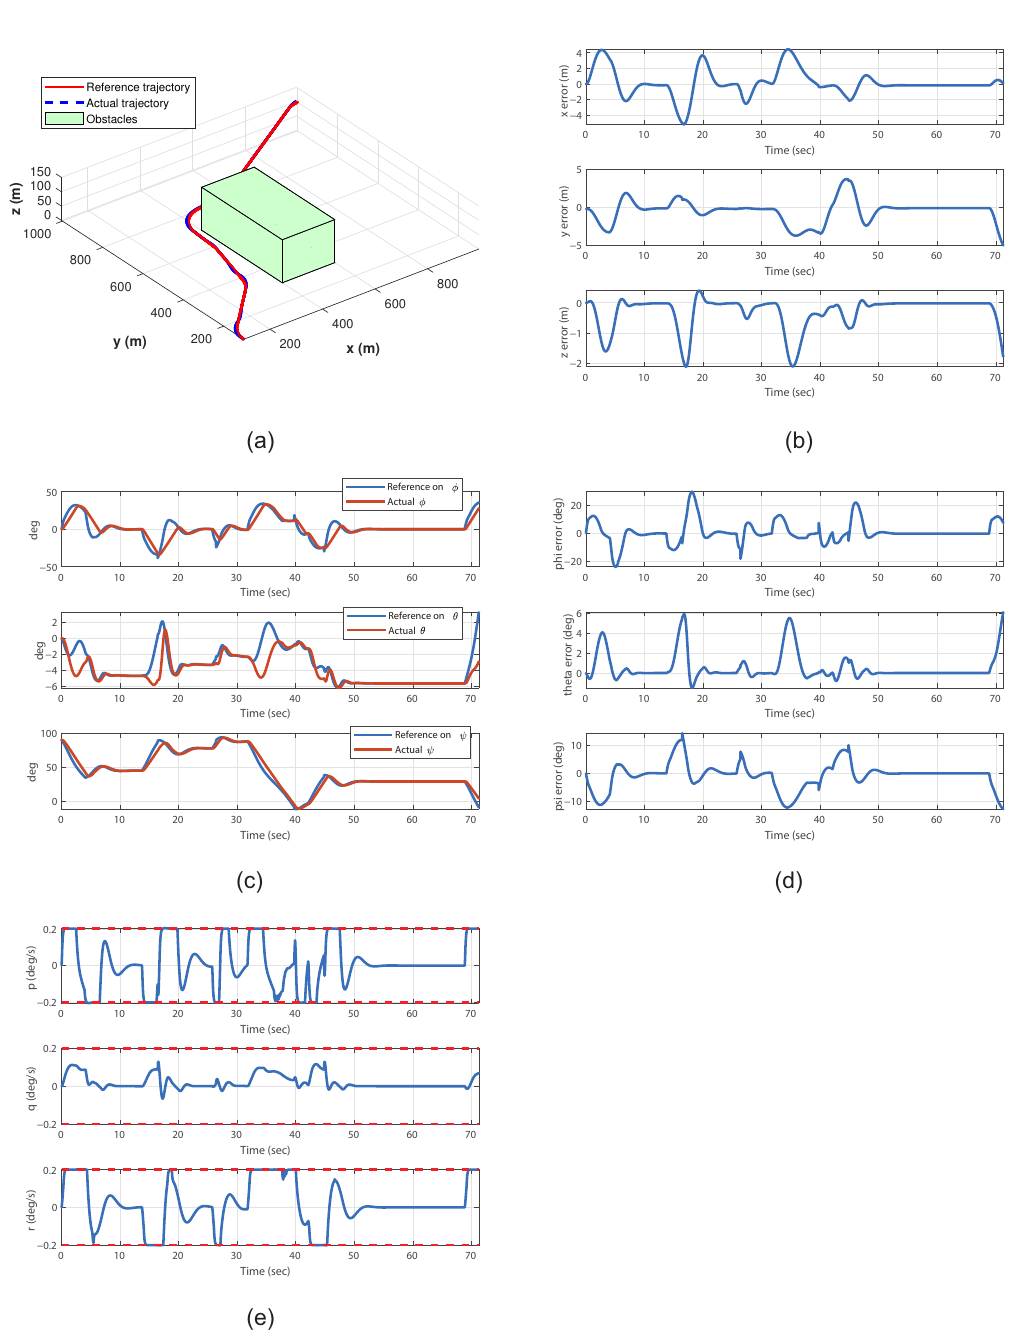
Figure 14. Path tracking results of center obstacle: ( a ) Path tracked in 3D. ( b ) Position error. ( c ) Atti- tude. ( d ) Attitude error. ( e ) Constrained angular